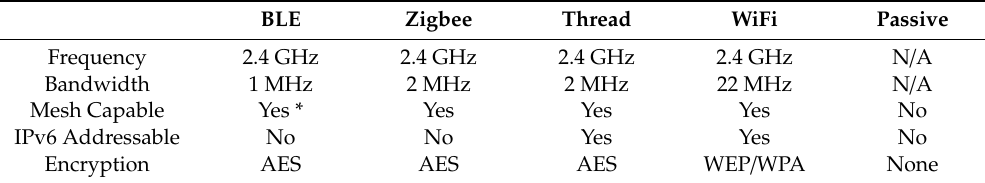
Table1. Comparisonofcommoncommunicationprotocols. BLE—BluetoothLowEnergy; IPv6—Internet Protocol version 6; N / A—not